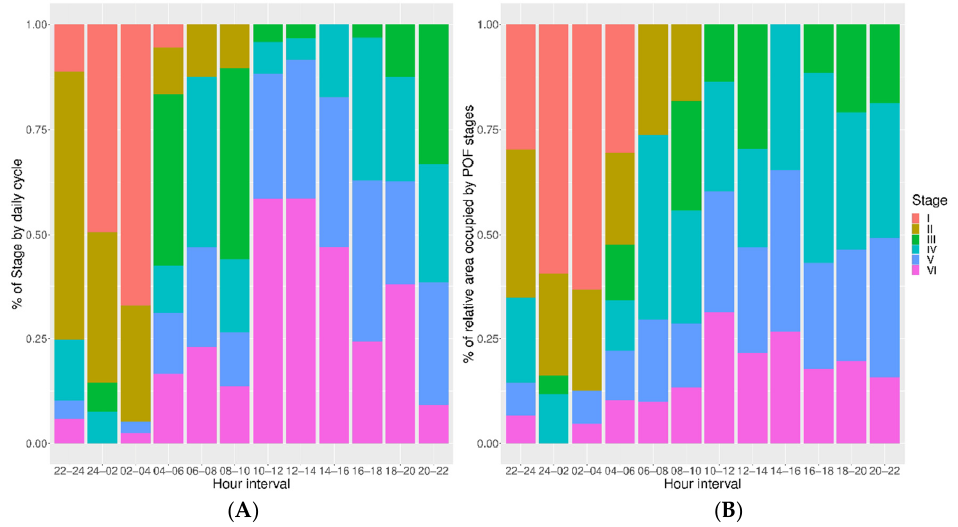
Figure 5. ( A ) Occurrence of postovulatory follicle (POF) stages (I to VI) standardized for the number of sampled females showing POFs in the ovaries, and ( B ) standardized average relative area occupied by POF stages (I to VI), per two hour-long intervals.